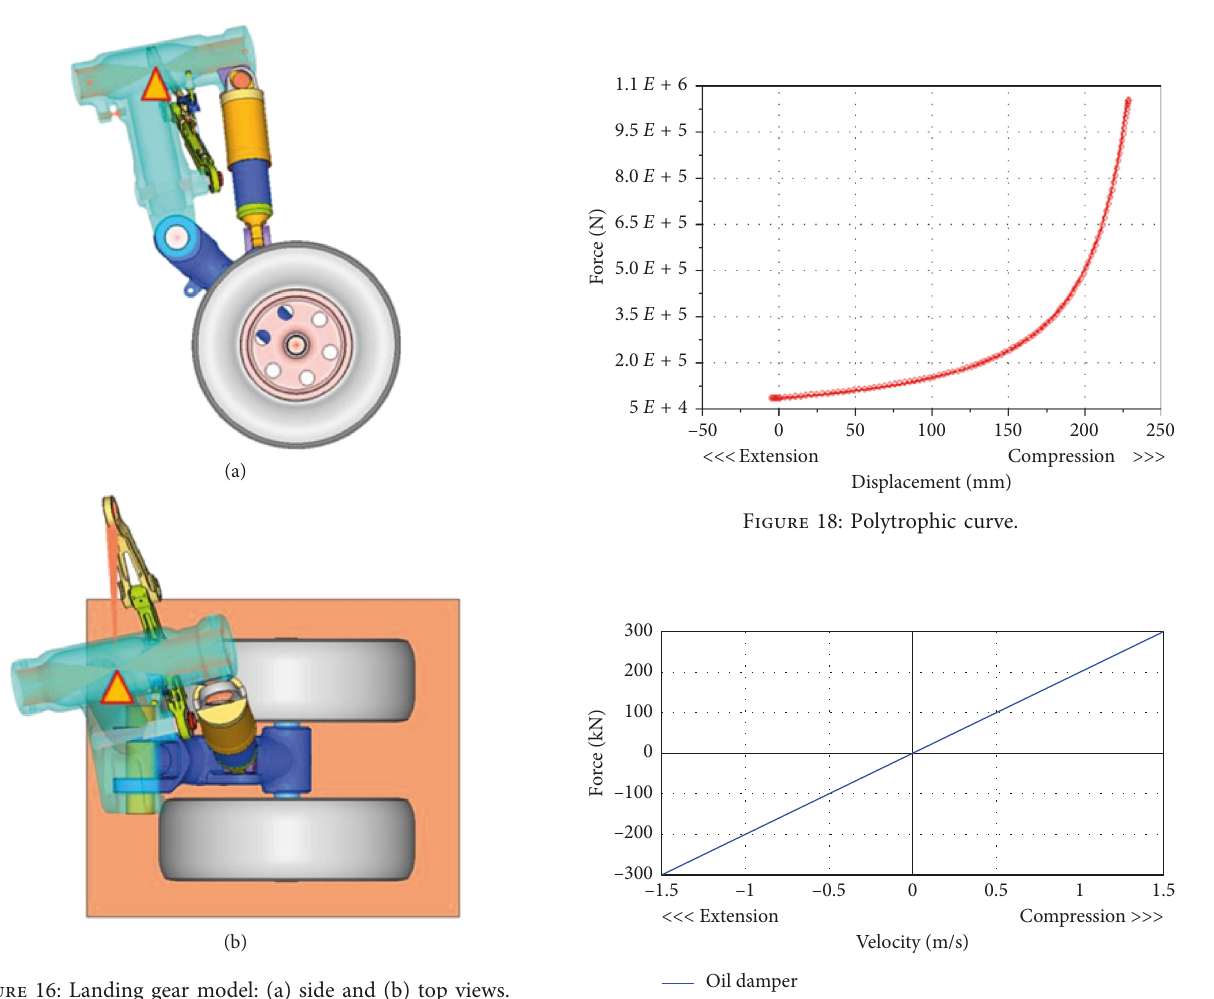
Figure 17: Modelling of the shock absorber.